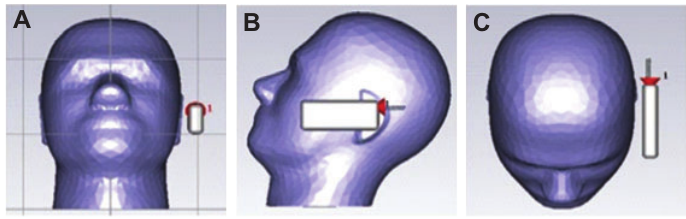
Figure 2 (A) Front view. (B) Right view. (C) Top view.